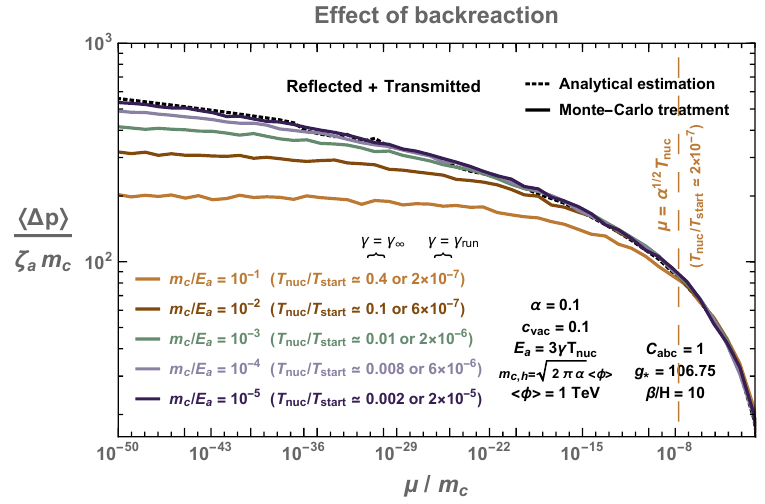
Figure 16 . We display here the average momentum transferred to the wall ∆ p as a function of the IR cut-off µ , both in some units of m c . In contrast to the analytical result in dotted , cf. Eq (4.15), which overestimates the exchanged momentum in the limit µ → 0 , the MC simulation in solid accounts for the depletion of the incoming energy-momentum due to the successive boson emissions, see section 5.2. This implies a maximal number of boson emission and a maximal value for the exchanged momentum compatible with energy-momentum conservation. The impact of energy depletion is higher and higher as we decrease the incoming energy E a /m c . For simplicity, m c = m c,h in this